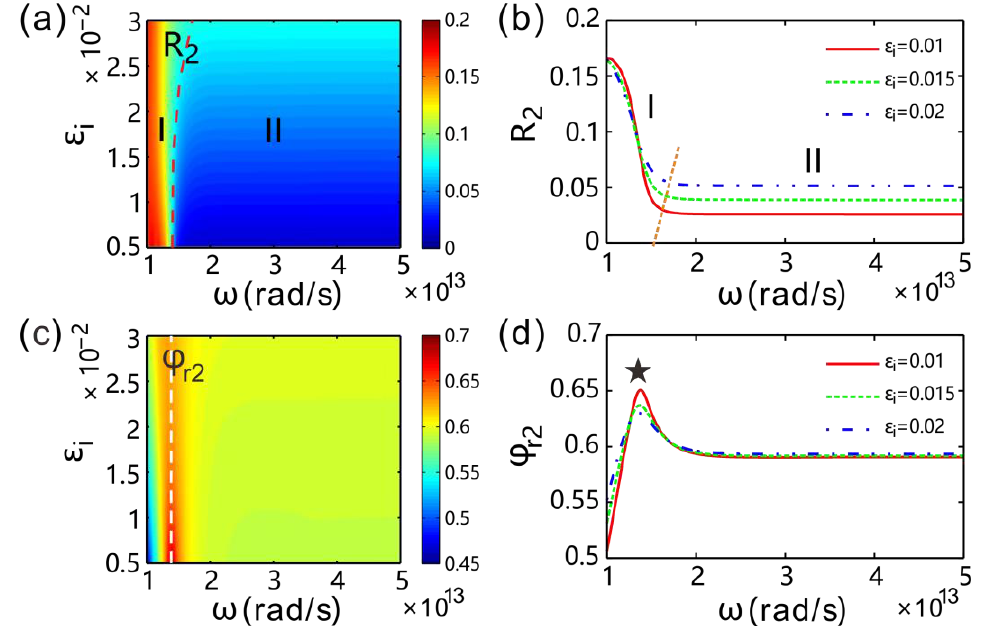
Figure 5. ( a , c ) The reflectance and phase of reflection coefficient varying with the permittivity and angular frequency for light incident from the right, respectively. ( b , d ) The reflectance and phase of reflection coefficient varying with the angular frequency for three different permittivities ε i = 0.01, 0.015 and 0.02, respectively.